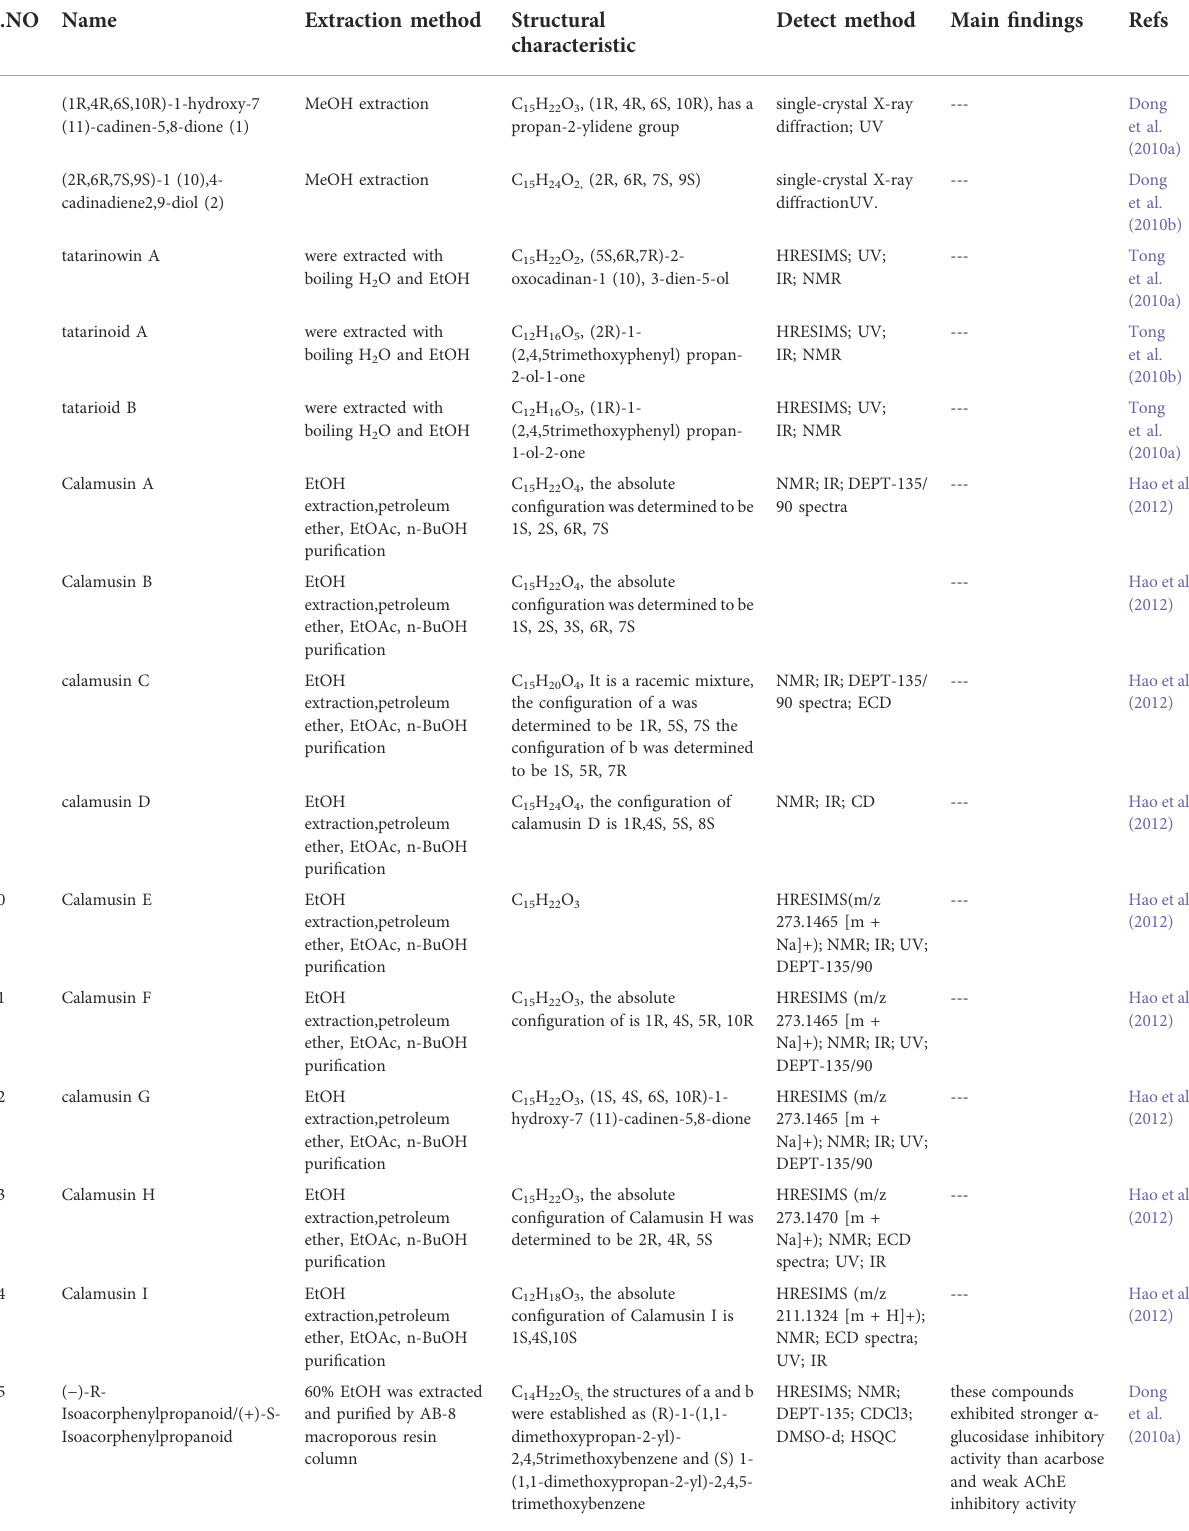
TABLE 2 List of volatile oil